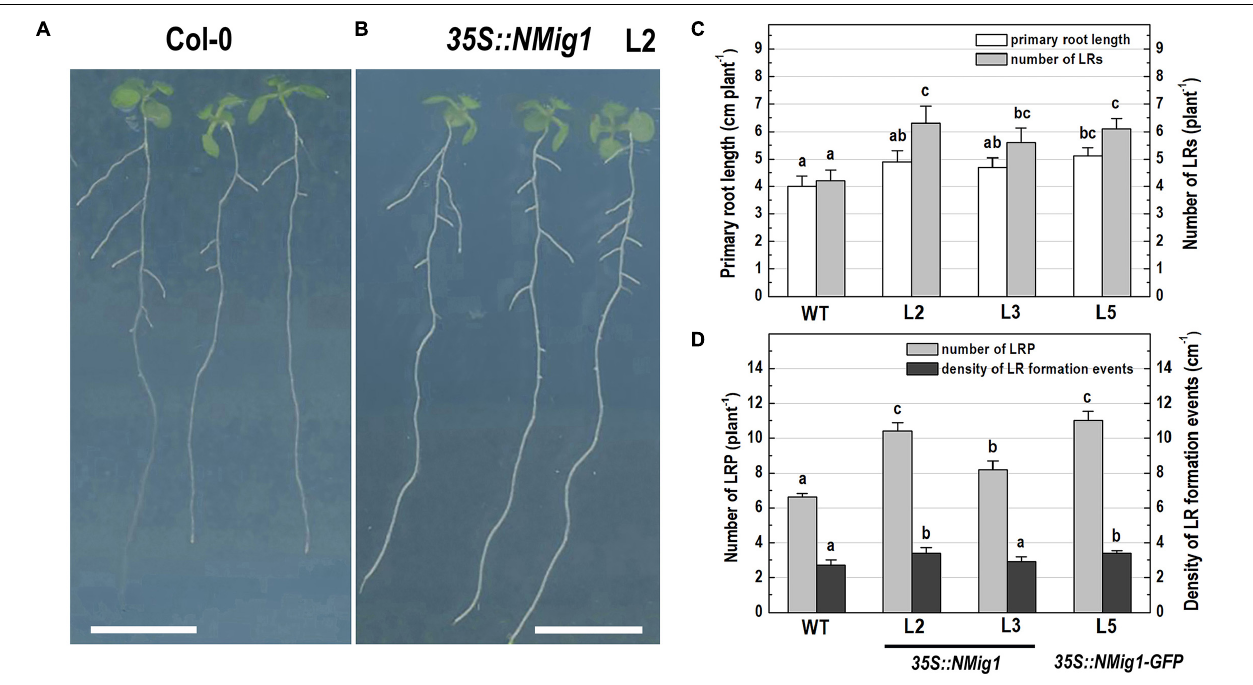
FIGURE 3 | Primary root length and lateral root development of 10-day-old wild-type Col-0 seedlings (A), and transgenic lines overexpressing NMig1 (L2, L3, and L5) (B) under optimal growth conditions: (C) average length of the primary root and number of lateral roots; (D) number of lateral root primordia and density of lateral root formation events. Different lowercase letters indicate statistically significant difference ( p ≤ 0.05). Scale bar = 1.0 cm.